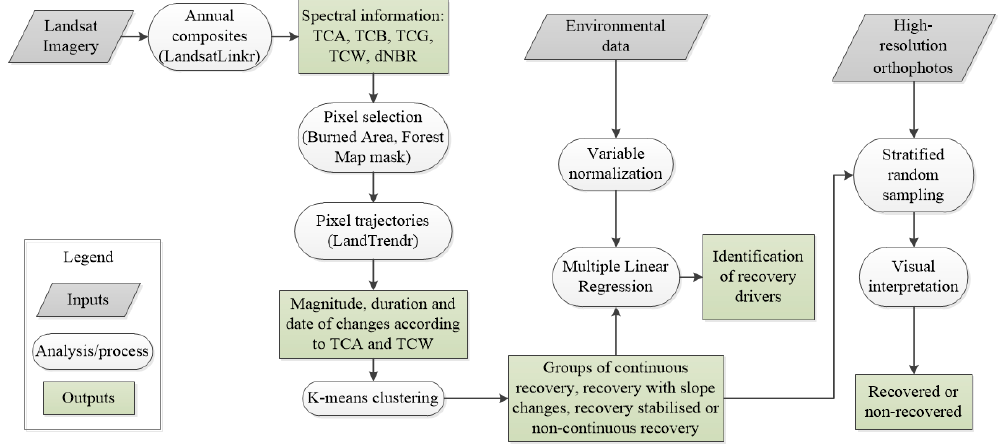
Figure 2. Flowchart of the methodology.